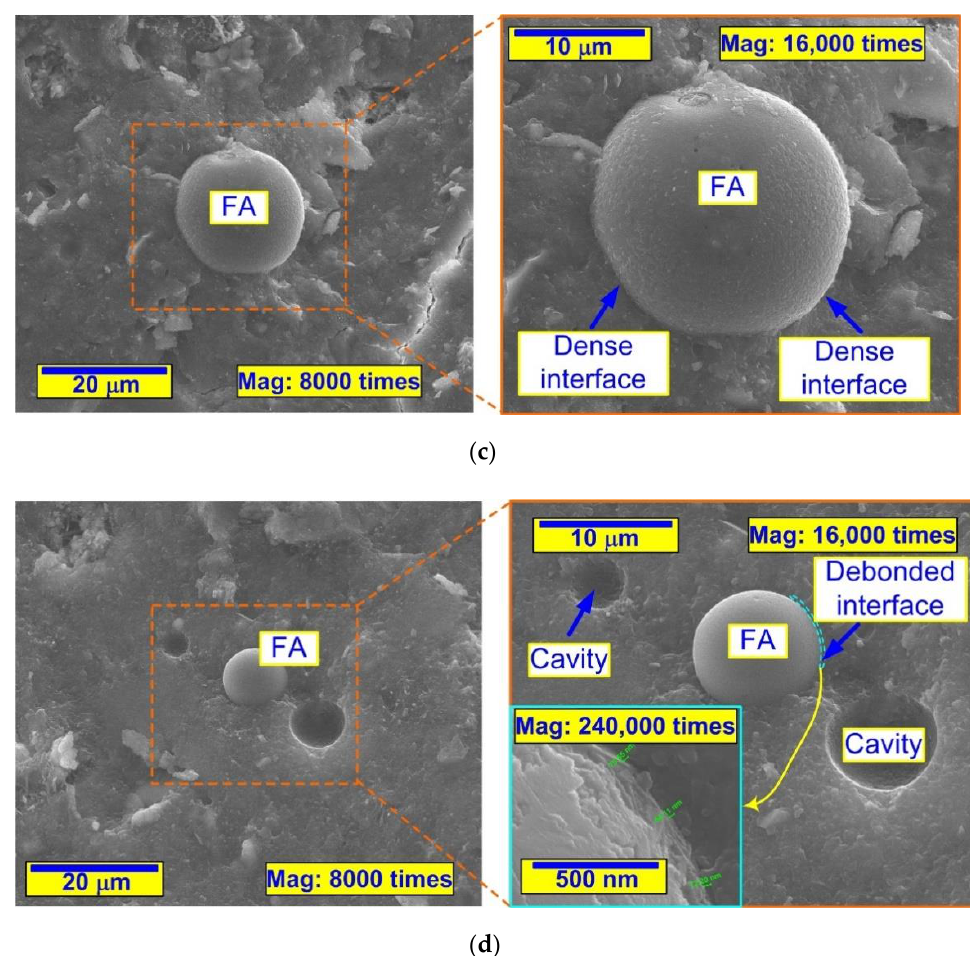
Figure 3. SEM micrographs of analyzed quaternary concretes including SCMs: ( a ) REF, ( b ) Q1, ( c ) Q2, ( d ) Q3; CH—calcium hydroxide, C-S-H—calcium silicate hydrate, E-ettringite, FA-fly Table 8. Morphology of the matrix of analyzed quaternary concretes.